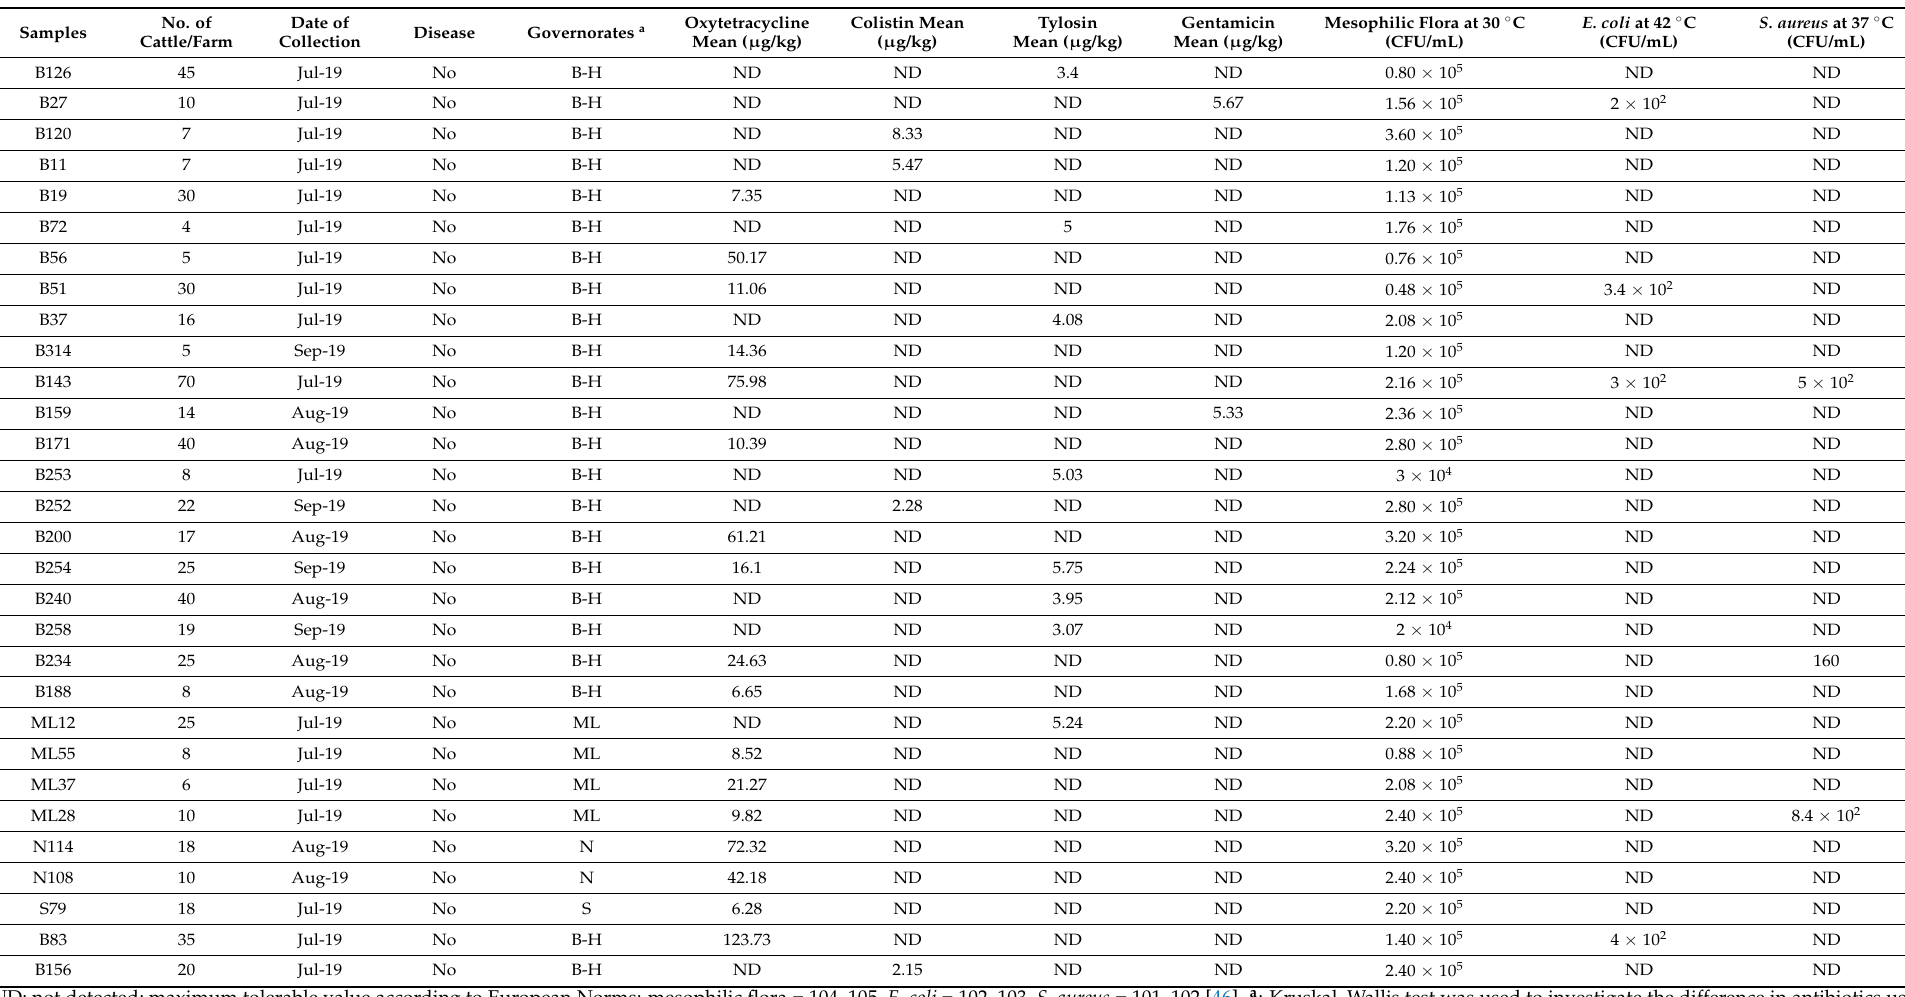
Table 8. Prevalence of microbial contamination by mesophilic flora, E. coli , and S. aureus of raw milk samples with antibiotic residues according to the farm locations, and the number and the health issues of cattle per